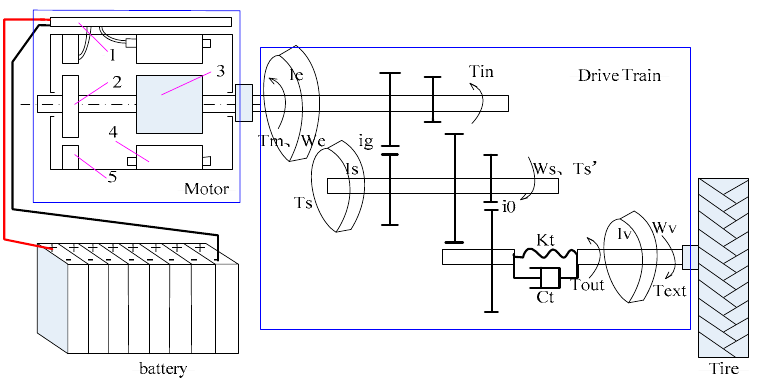
Figure 1. Diagram of an electric tractor. Note: 1—electronic commutation switch circuit, 2—sensor rotor, 3—main rotor, 4—main stator, and 5—sensor stator.